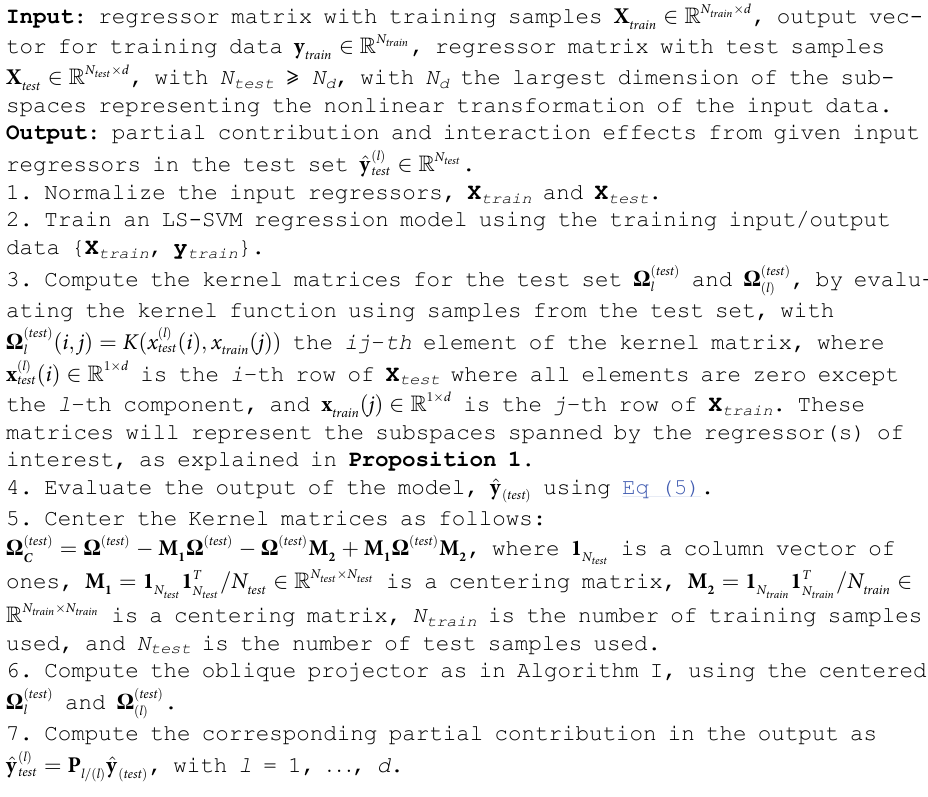
Algorithm II . Out-of-Sample Extension for